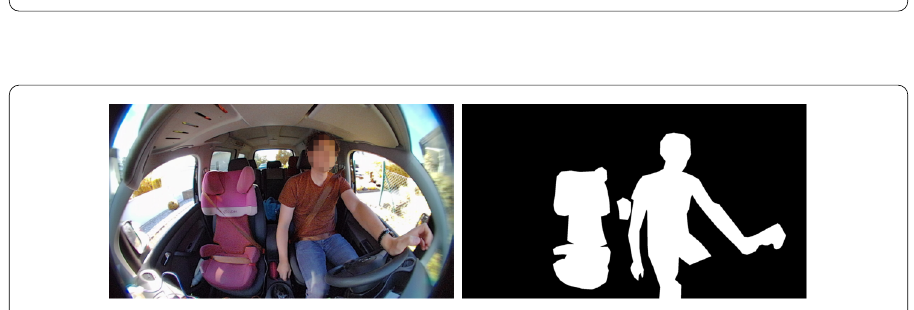
Figure 7 An image of the training set (left) and its corresponding gray scale ground truth instance segmentation mask (right)